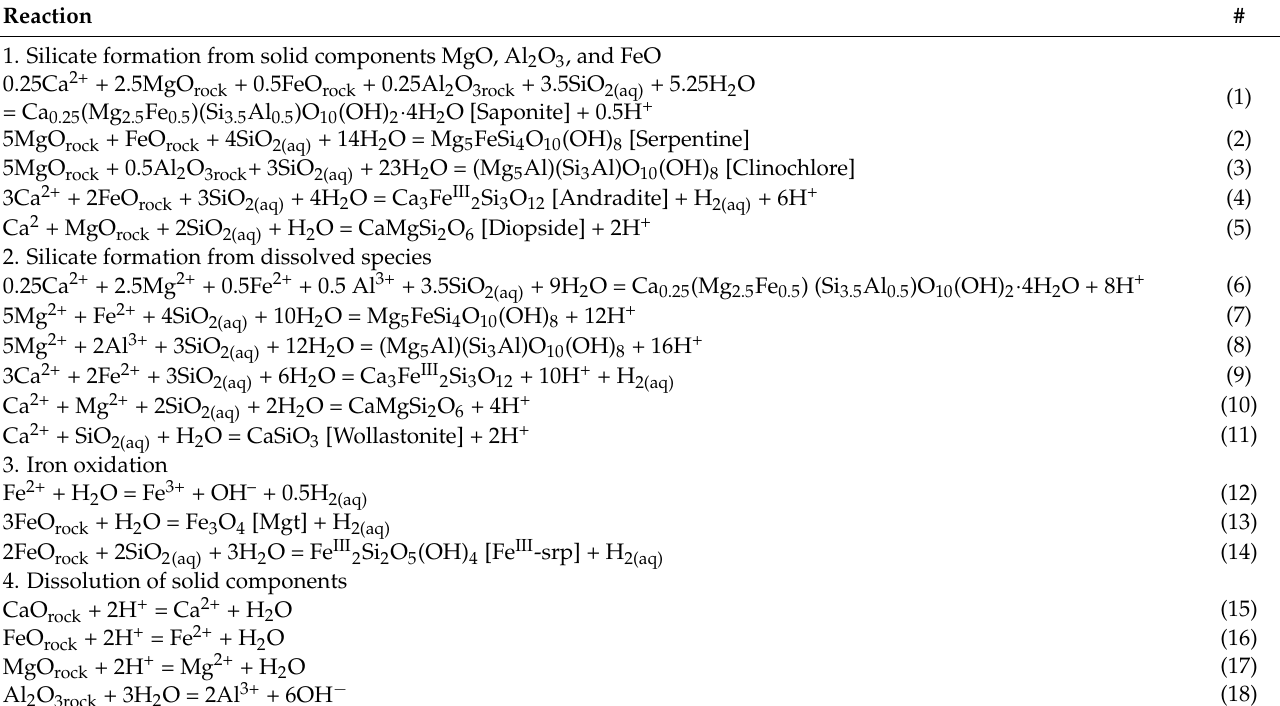
Table 7. List of water-rock